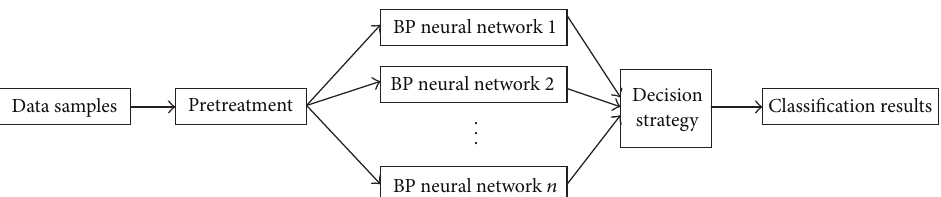
Figure 2: The flow of the algorithm.